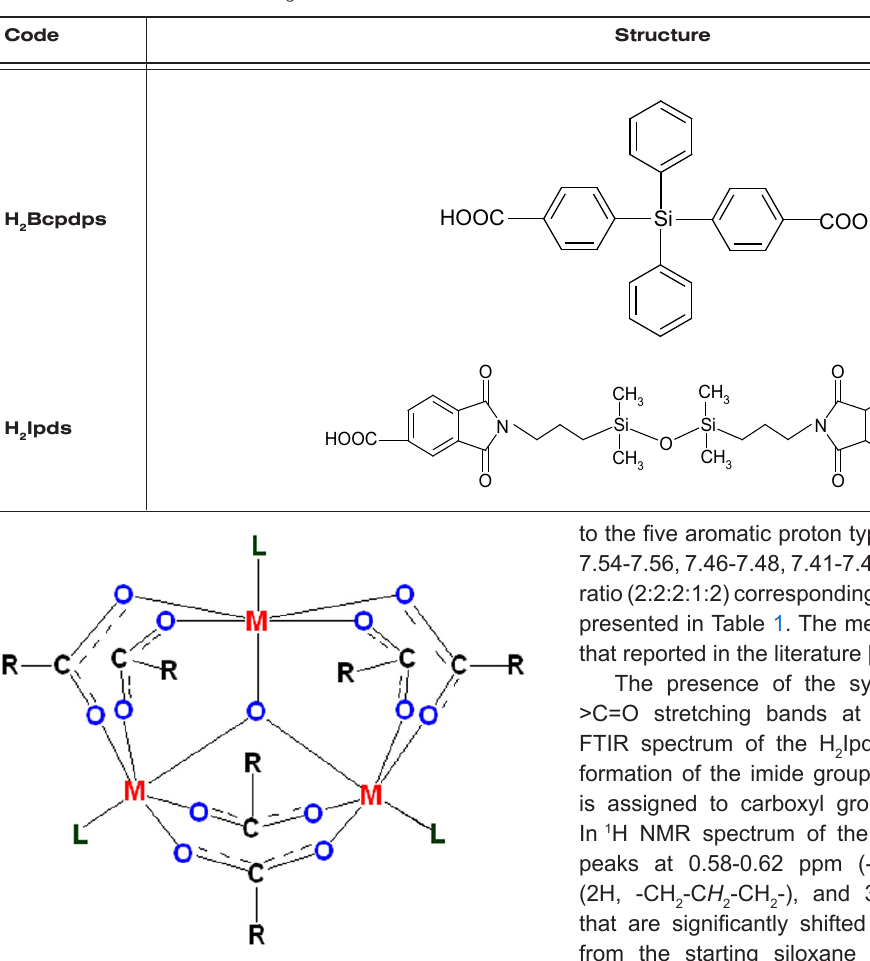
O(OOCR) (L) ] 1/0 , of majority 3 6 3